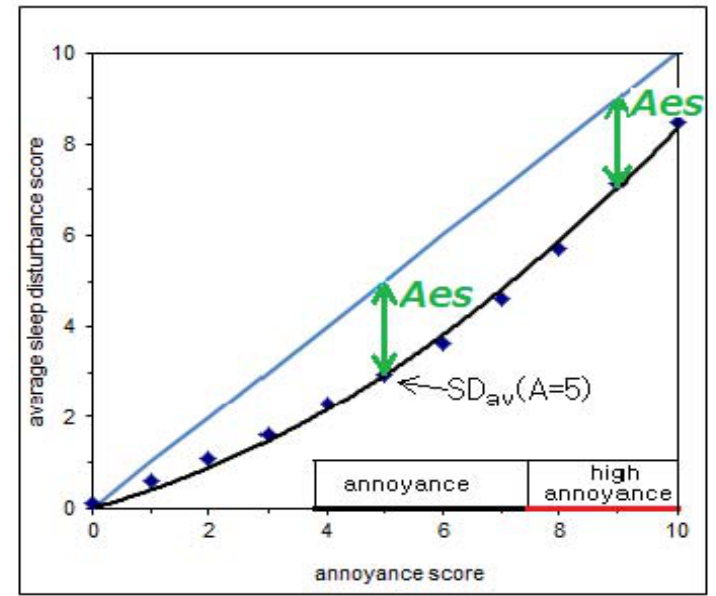
Figure 2. Relation between average sleep disturbance score (SD illustrates annoyance ranges and Annoyance excess score